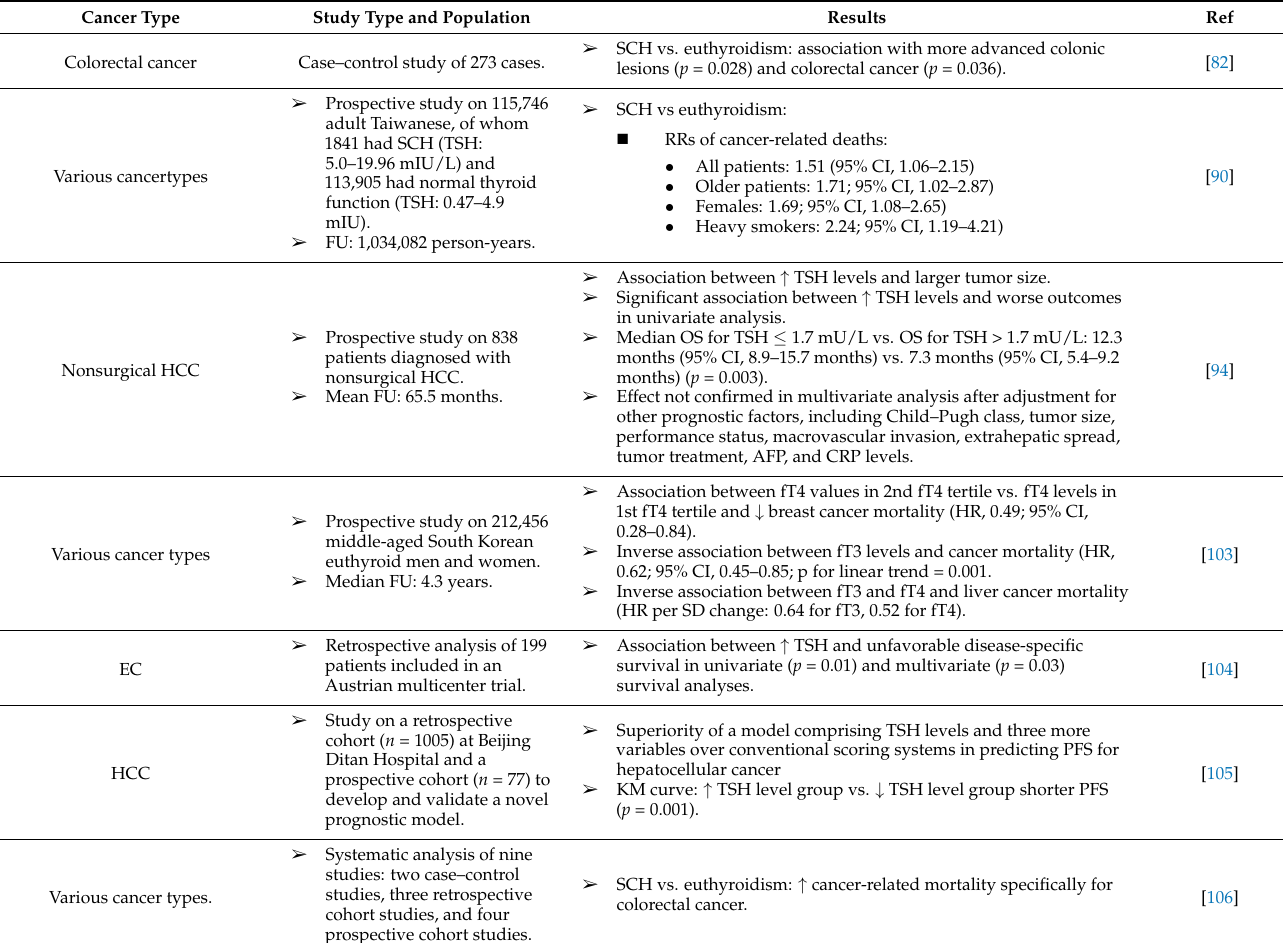
Table 3. Clinical data indicating hypothyroidism or decreased THs, even within the euthyroid range as predictors, of unfavorable